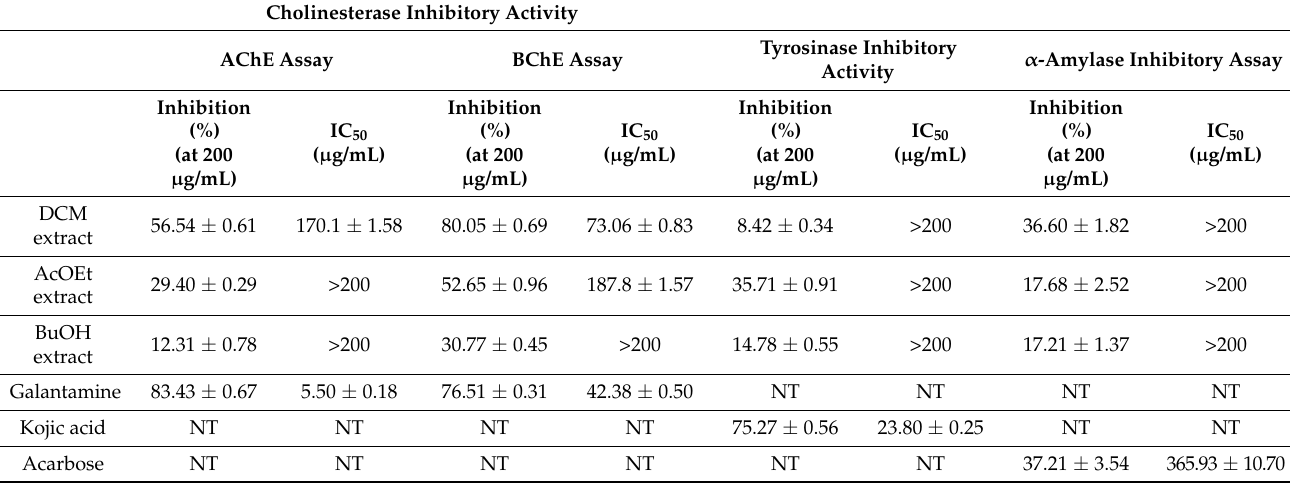
Table 4. Enzyme (cholinesterase, tyrosinase, α -amylase) inhibitory activities of C. nepeta extracts. Cholinesterase Inhibitory